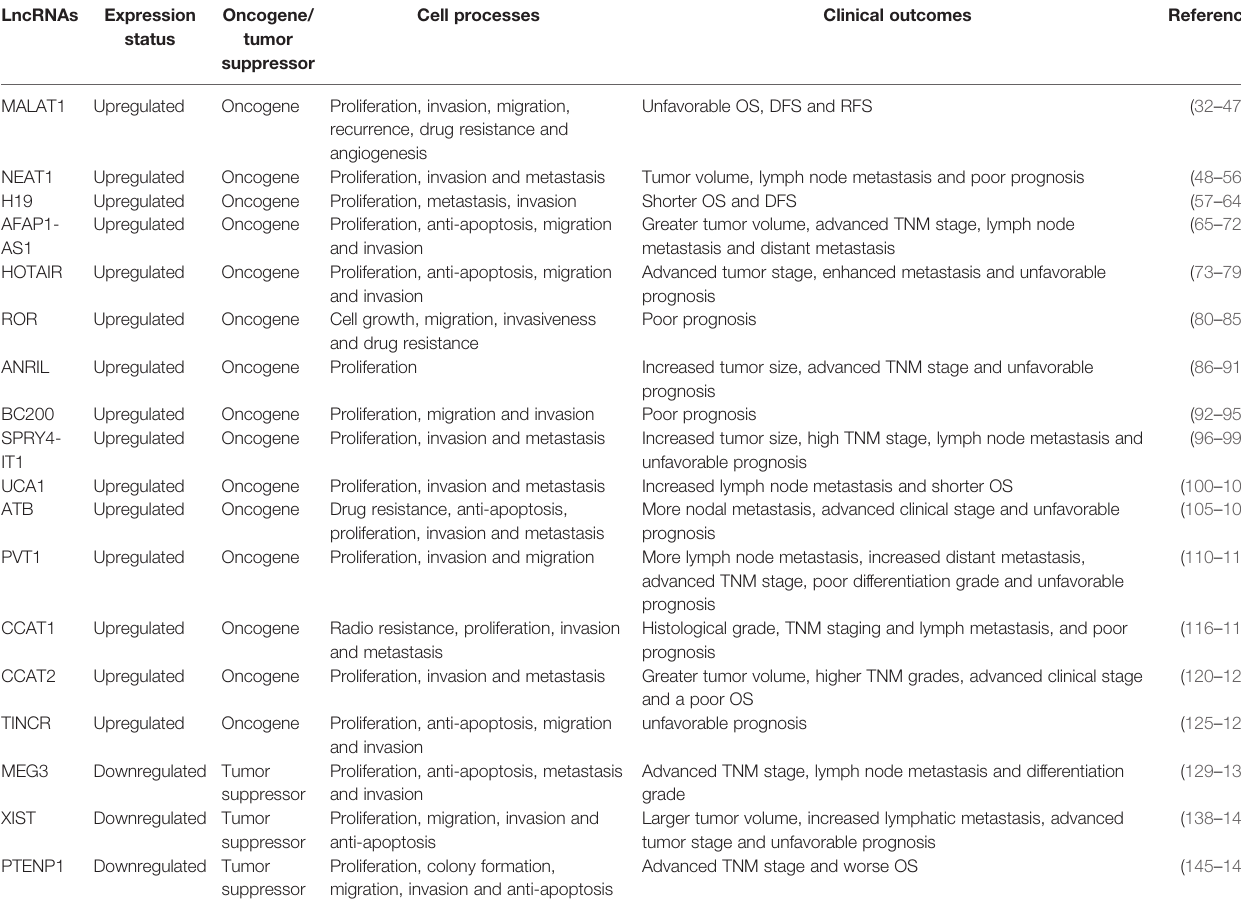
TABLE 1 | Summary of breast cancer-associated